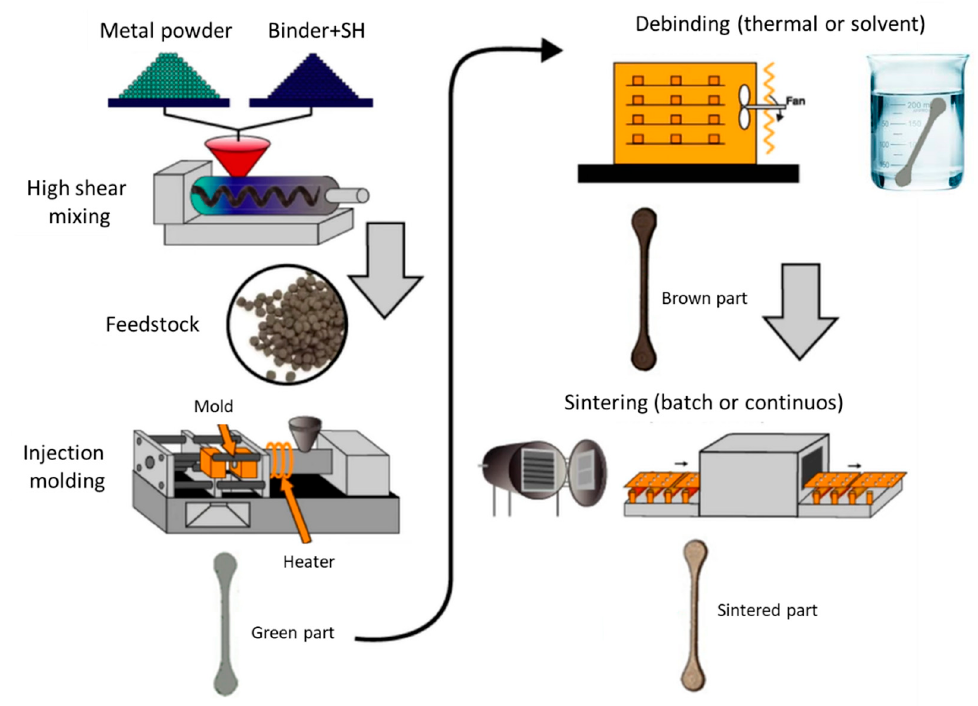
Figure 1. Steps involved in metal injection molding (MIM) process combined with the space holder (SH)